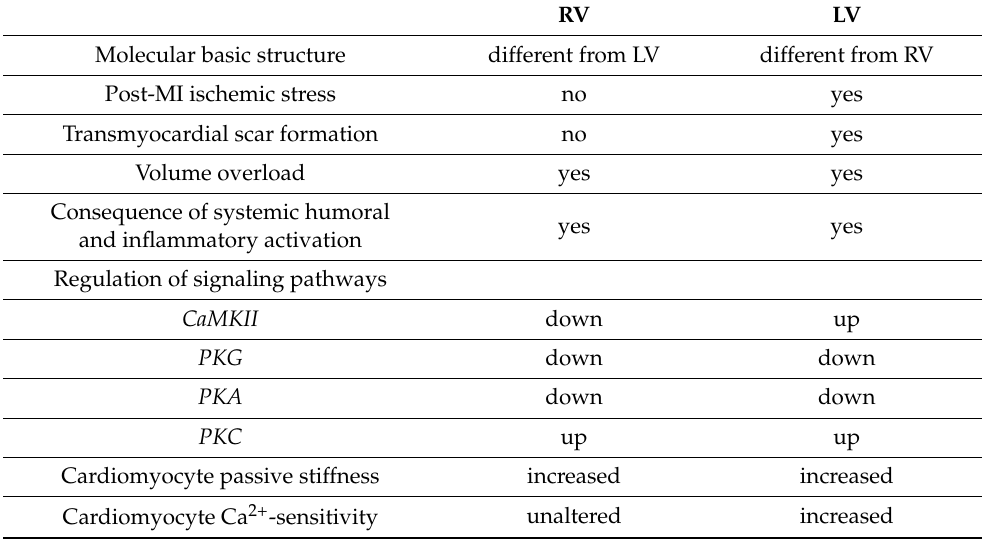
Table 1. Summary of interventricular differences of the post-ischemic heart.